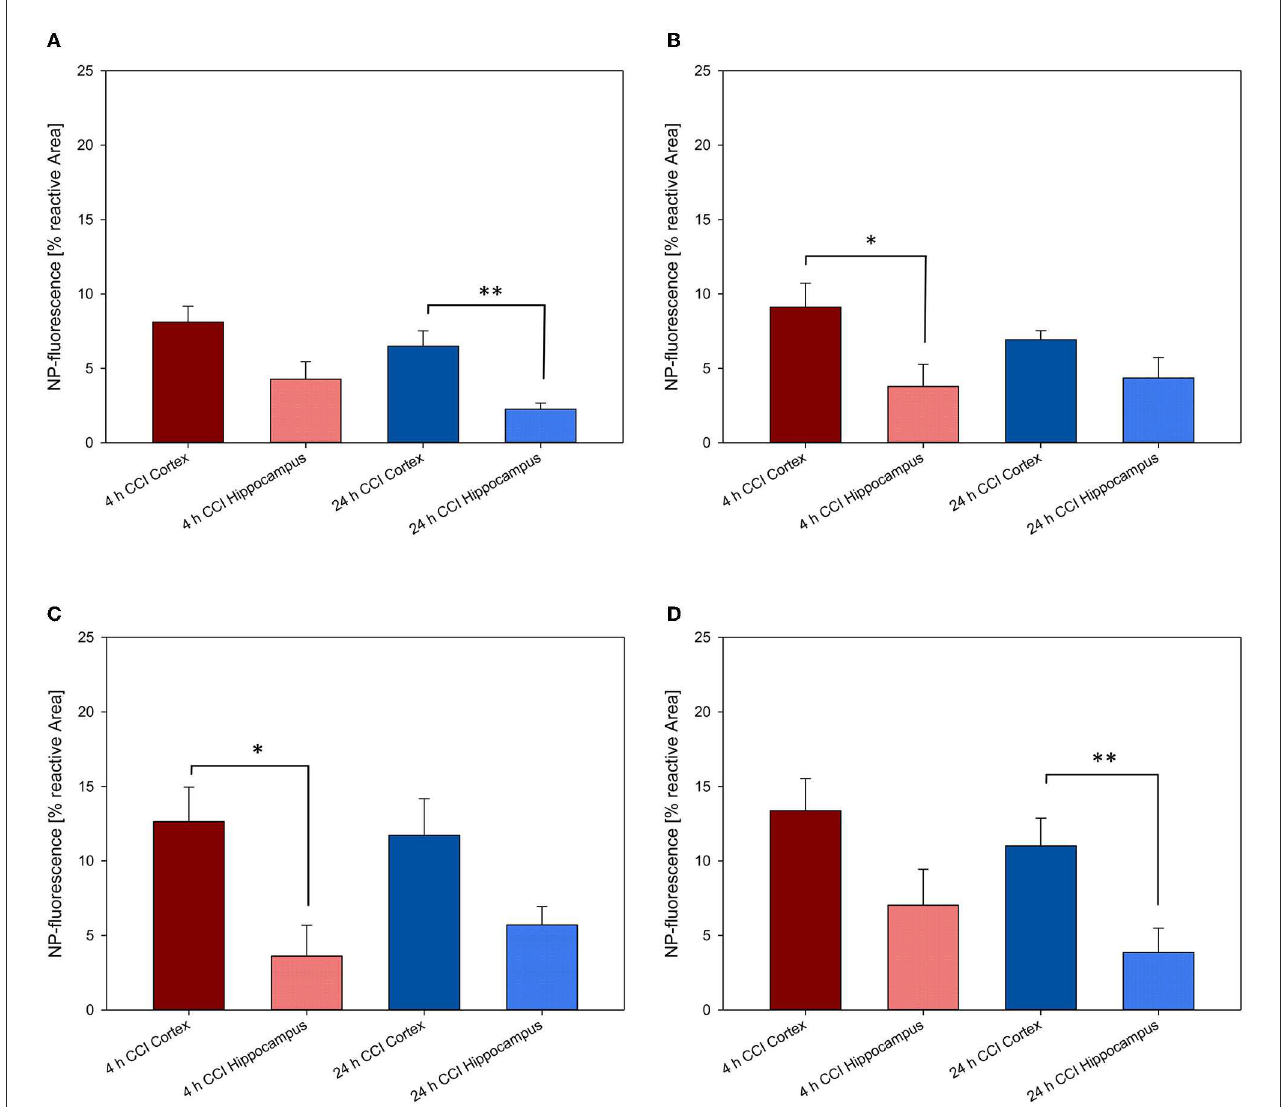
FIGURE9 Comparison of NP uptake between the cortical and hippocampal area within the CCI-injured hemisphere at 4 and 24h after intravenous injection. The accumulation of PFDL-Tw (A) , PFDL-SDS (B) , PLLA-Tw (C) , and PLLA-SDS (D) nanoparticles was assessed as the percentage of reactive fluorescent area in relation to the total area of the ROI at 40 × magnification. Paired t -tests showed a clear trend to higher NP uptake in the cortex compared to the hippocampus, located away from the CCI area. Bars express means ± SEM. ** p < 0.01, * p <